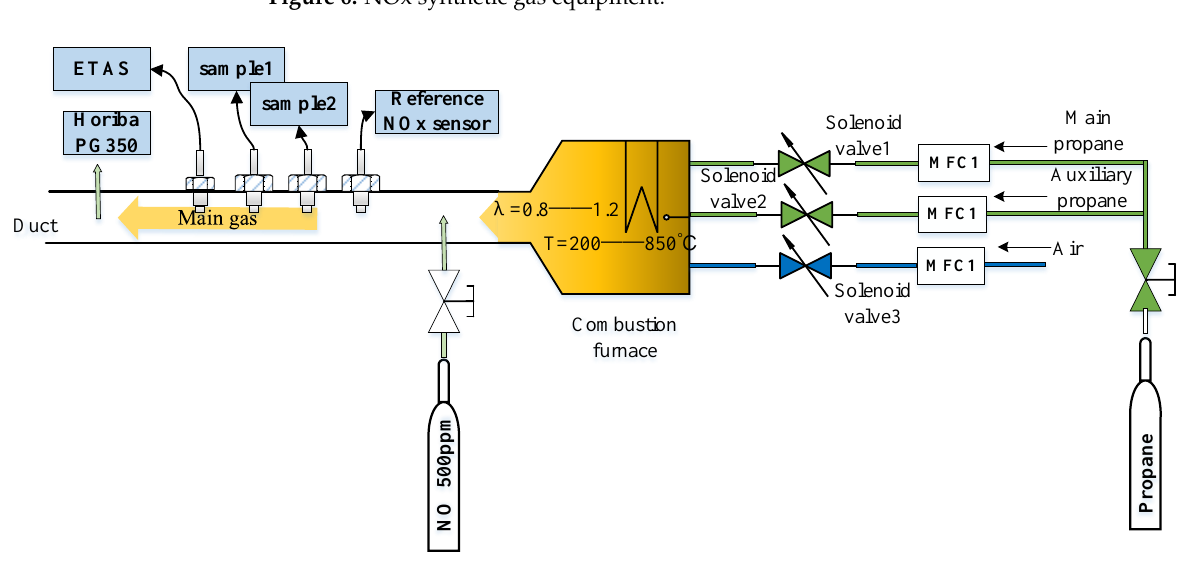
Figure 7. Propane burner stand apparatus.